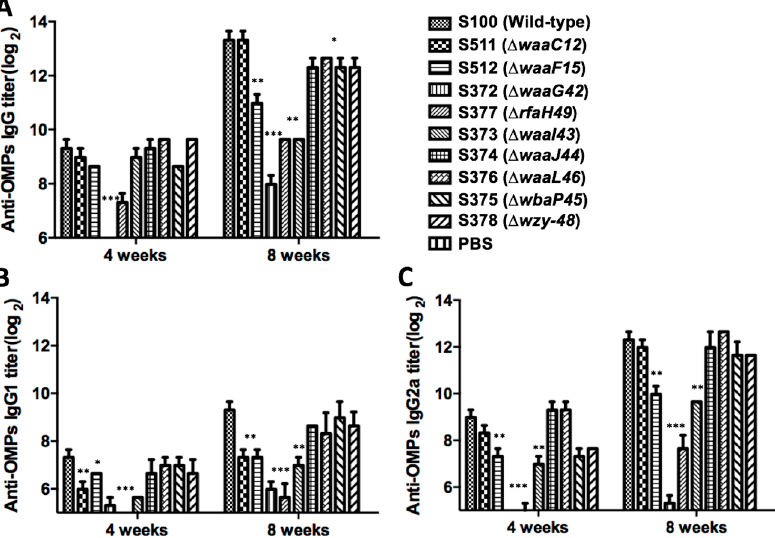
Figure 4. Serum antibody responses in mice immunized by the intranasal route. Total serum IgG specific for OMPs from S. Typhimurium ( A ), IgG1 specific for OMPs from S. Typhimurium ( B ) and IgG2a specific for OMPs from S. Typhimurium ( C ) were measured by enzyme-linked immunosorbent assay (ELISA). Each group has eight mice. The data represented the reciprocal anti-IgG antibody titer in pooled sera from mice immunized with OMPs from parent strain S100 and its mutants with truncated core or O -antigen at the indicated weeks after immunization. The error bars represented variations between triplicate wells. The mice were boosted at Week 5. *** p < 0.001; ** p < 0.01; * p < 0.05; compared to titers from mice immunized with OMPs isolated from wild-type strain S100. No immune responses were detected to OMPs in mice immunized with PBS (reciprocal titer < 1:50). Immune responses (IgG, IgG1 and IgG2a) against OMPs from S. Typhimurium were below the detection level in the serum from mice immunized with OMPs from mutants ∆ waaG and ∆ rfaH at four weeks (reciprocal titer < 1:50).